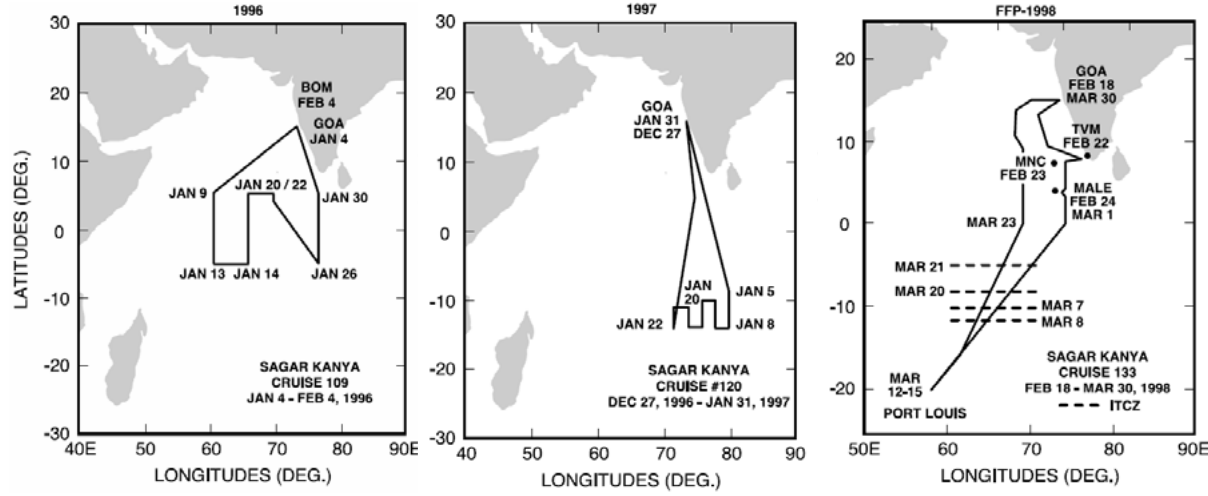
Fig. 10. Cruise tracks of the 1996, 1997 and 1998 RV Sagar Kaya cruises (redrawn from Mitra, 1999, copyright 1999 by the Indian Academy of Sciences, reproduced with permission). Figure 4.1.1. Cruise tracks of the 1996, 1997 and 1998 RV Sagar Kaya cruises [redrawn from Mitra (1999), permission pending]. Table 4. Listing of the ship cruises performed during the pre- INDOEX and INDOEX